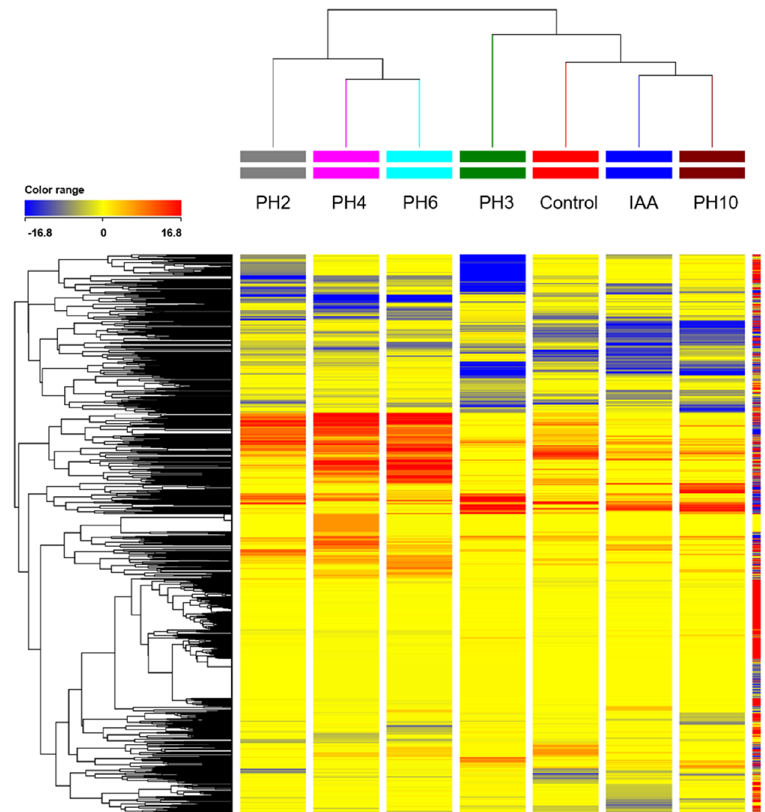
Figure 3. Unsupervised hierarchical cluster analysis (HCA) carried out from UHPLC-ESI/QTOF-MS metabolomics analysis of tomato leaves treated with protein hydrolysate (PH) applications. Indole-3- acetic acid (IAA 1 mM) was used as positive control. The fold-change-based heat map was used to build hierarchical clusters (linkage rule: Ward; distance: